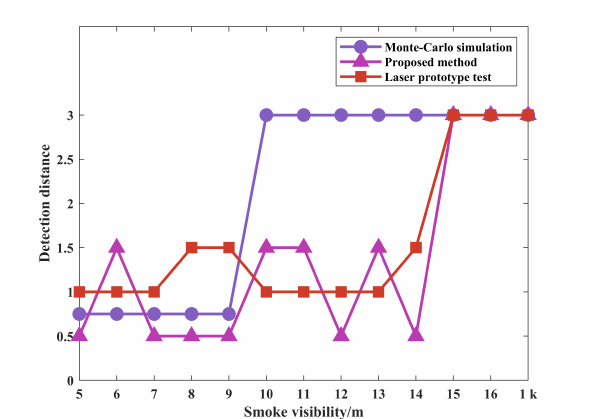
Figure 17. Detection distance